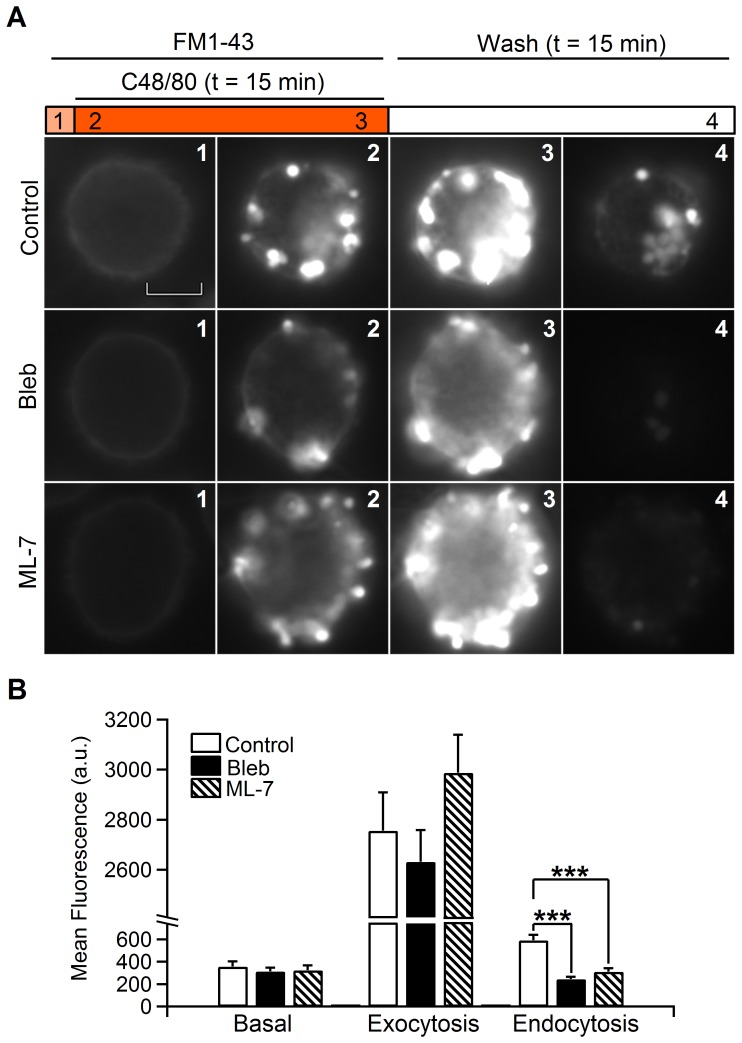
Inhibition of NM-2 activity through drug treatments produces decreased FM1-43 internalization.The standard protocol begins with an initial FM1-43 (4 µM) perfusion to label cells, followed by perfusion of C48/80 (100 µg/ml) in the presence of FM1-43 to stimulate secretion for 15 min. Finally, the extracellular FM1-43 label was removed by washing with a standard solution for 15 min (A). Cells that were treated with blebbistatin (5 µM) or ML-7 (5 µM) were previously incubated in a solution containing these drugs for 10 min. Panel A shows FM1-43 fluorescence images taken from control (Control) and Blebbistatin- (Bleb) or ML-7 (ML-7)-treated cells. From left to right: basal (1), at the beginning of the exocytosis (2), at the end of the exocytosis (3) and after removal of the extracellular dye (4). Internalized dye-labelled endocytic vesicles are evident as fluorescent spots within each cell (4). Mean fluorescence (arbitrary units, a.u.) data showing that basal and exocytic fluorescence (white bar, control; black bar, blebbistatin; and lined bar, ML-7) are equal for treated and non-treated cells. However, endocytic fluorescence was significantly lower for cells treated with blebbistatin or ML-7 (B). Scale bar: 5 µm. Error bars, S.E.M. ***p<0.001.